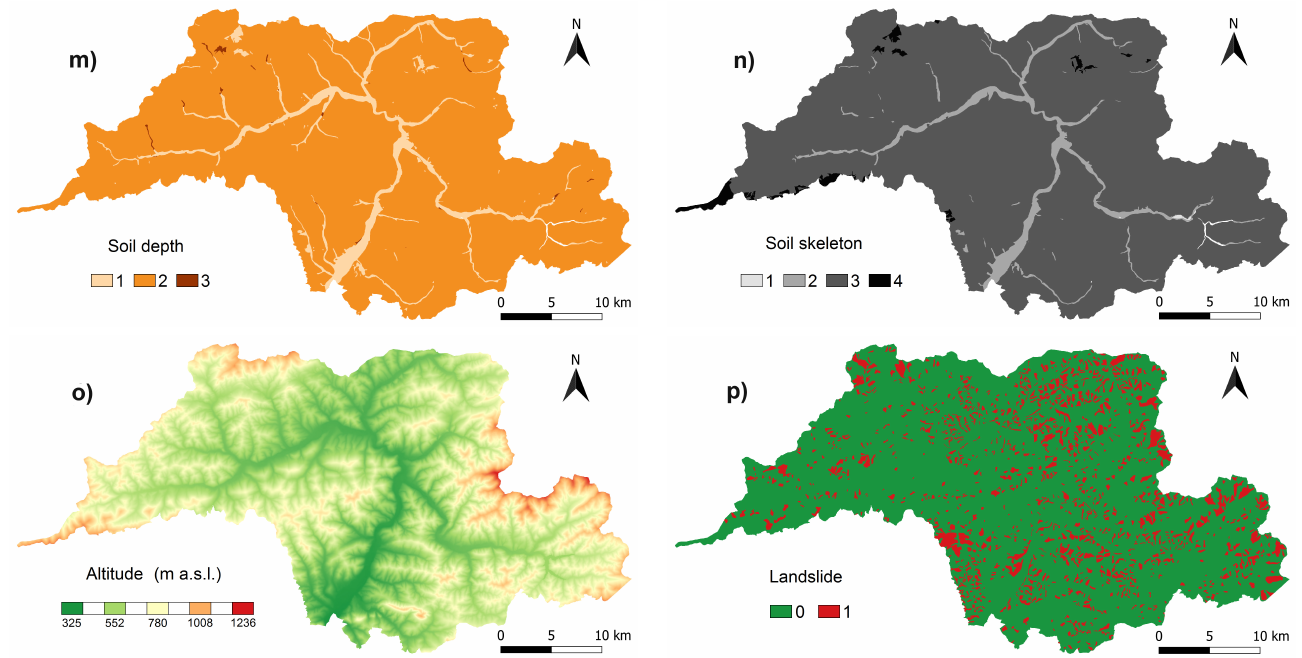
Figure 3. Maps of conditioning factors and the map of landslides used in this study: ( a ) Geological units, ( b ) Hydrogeological units, ( c ) Surface relief morphology, ( d ) Profile curvature, ( e ) Soil types, ( f ) Grain-size of soils, ( g ) Orientation, ( h ) Land cover, ( i ) Slope inclination, ( j ) Groundwater level, ( k ) Transmissivity coefficient, ( l ) Filtration coefficient, ( m ) Soil depth, ( n ) Soil skeleton, ( o ) Altitude, ( p ) Landslide (figure legends—see Section